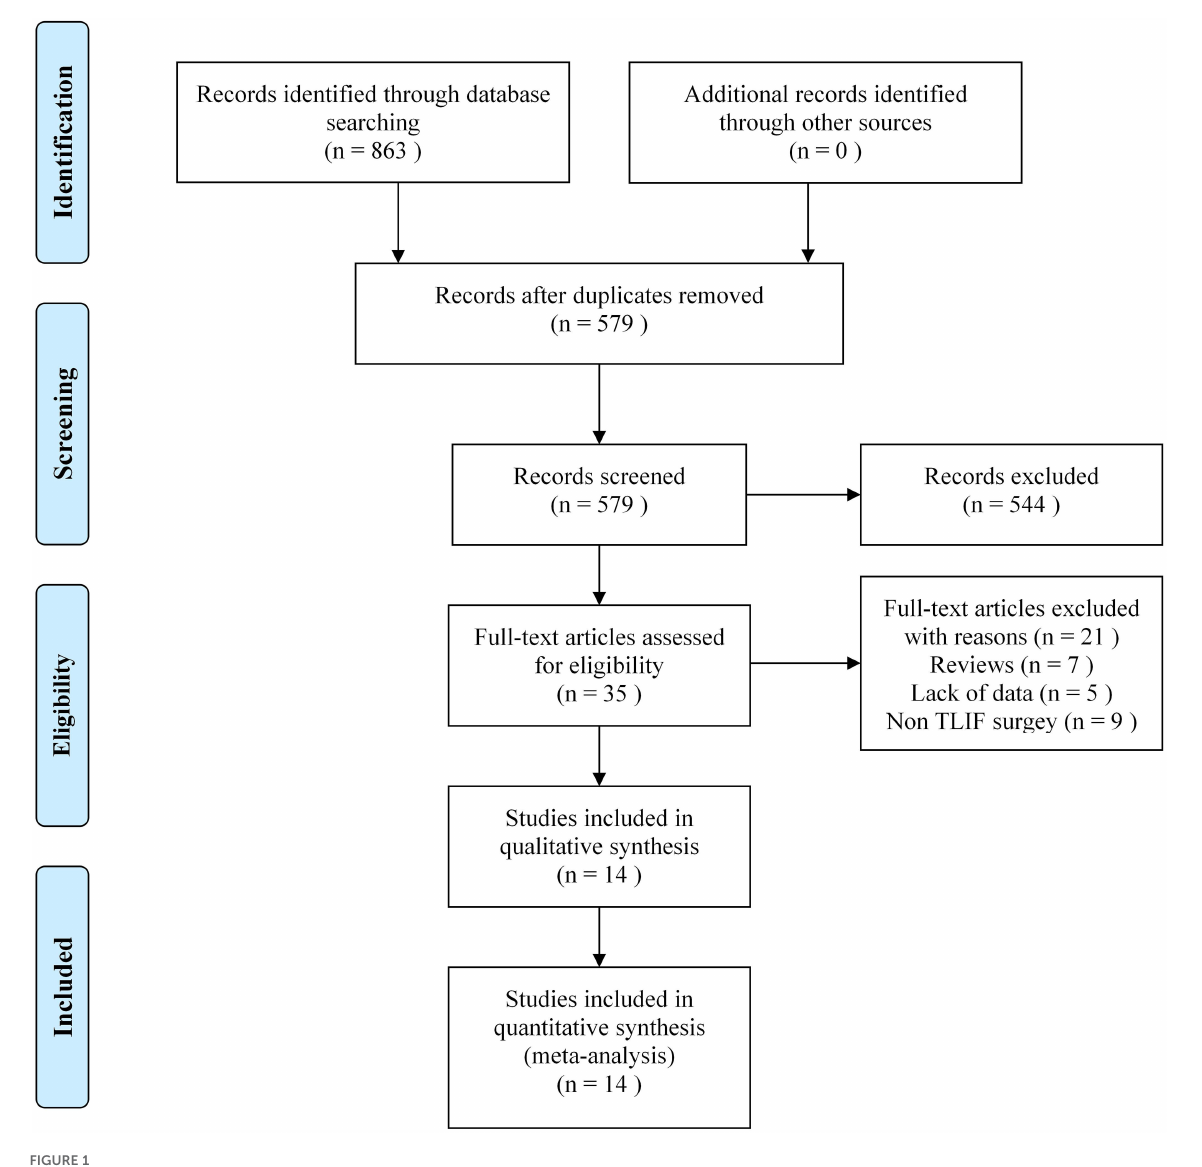
FIGURE1 Flow diagram of the study selection